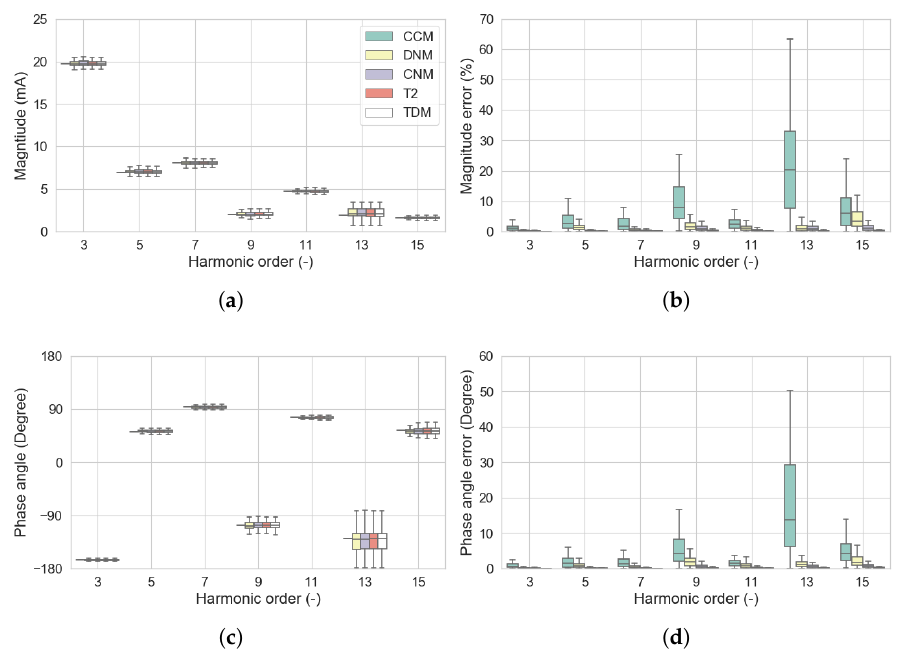
Figure 19. Comparison of the Type D LED lamp frequency domain models for peak-top voltage supply: ( a ) Magnitude; ( b ) Magnitude error; ( c ) Phase angle; and ( d ) Phase angle